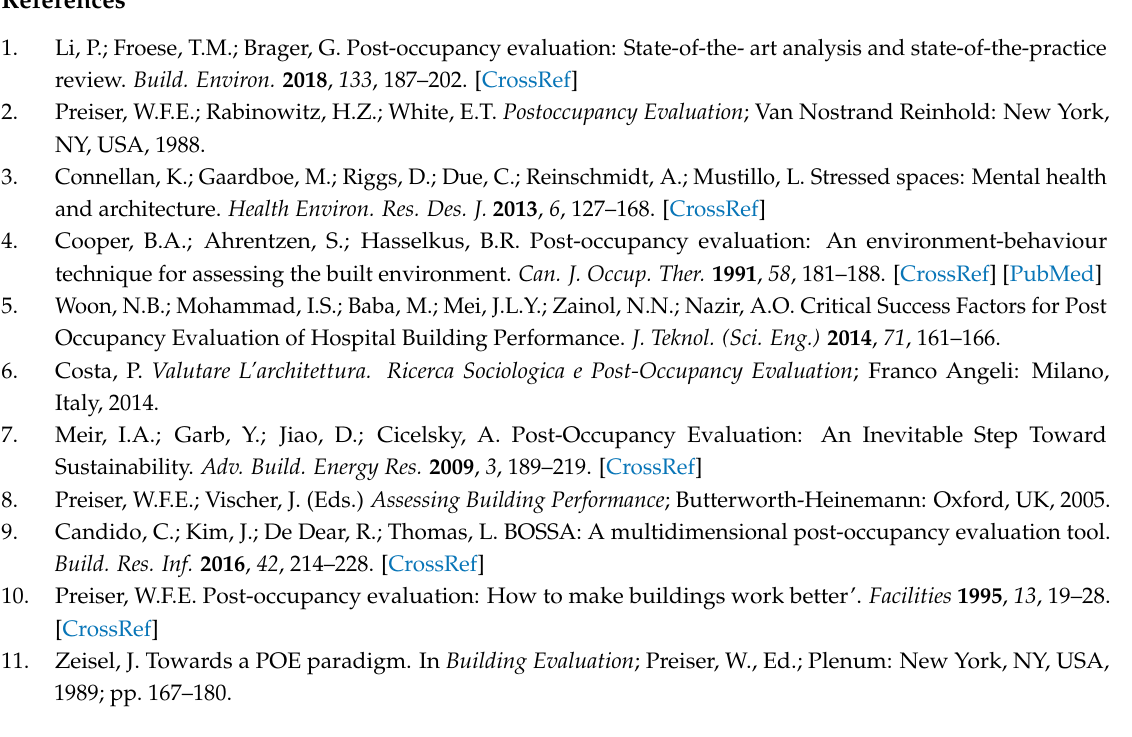
Table S1: List of POE studies on healthcare facilities, Table S2: List of the 44 tools found in the review, Table S3: List of the 13 tools included in the review and their main characteristics, Table S4: Relationship between EBD dimensions and tools’ indicators, Table S5: Indicators divided per categories and